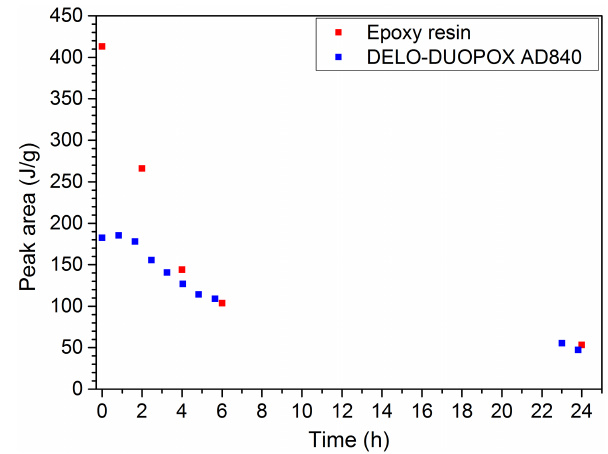
Figure 12. DSC measurement of EP resin and the 2C adhesive (DELO-DUOPOX AD840) cured for different times at room tem- perature.